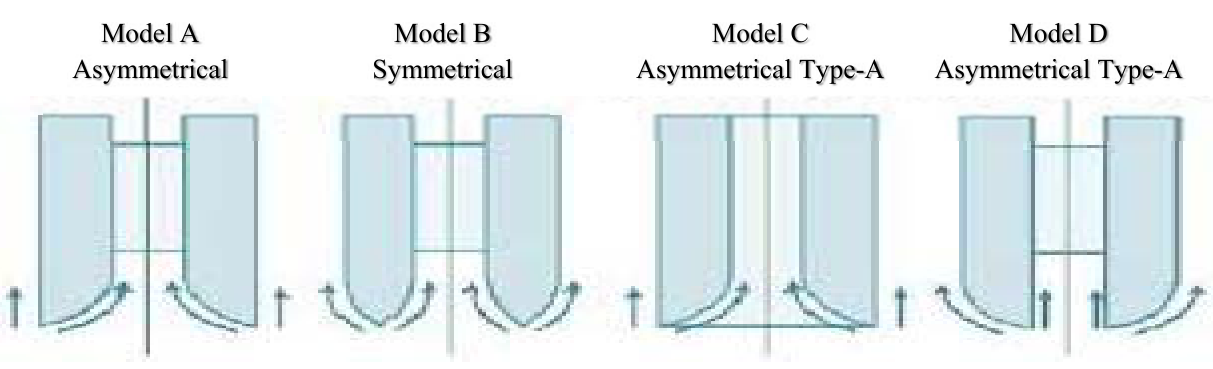
Figure 3. Multi Hull